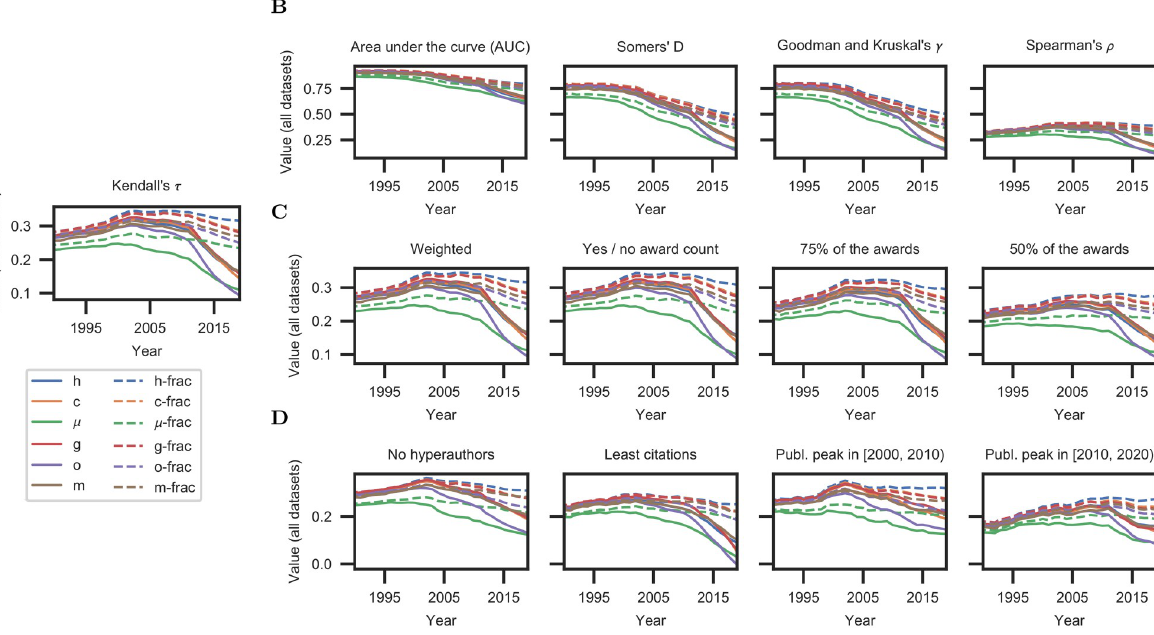
Fig 3. Controlled experiments that test the robustness of the findings. ( A ) Reference result from the main experiments (cf. Fig 2A(top)). ( B ) Corresponding results with other correlation statistics. ( C and D ) Results in different conditions: using subsets of awards, researchers, and different mechanisms for counting